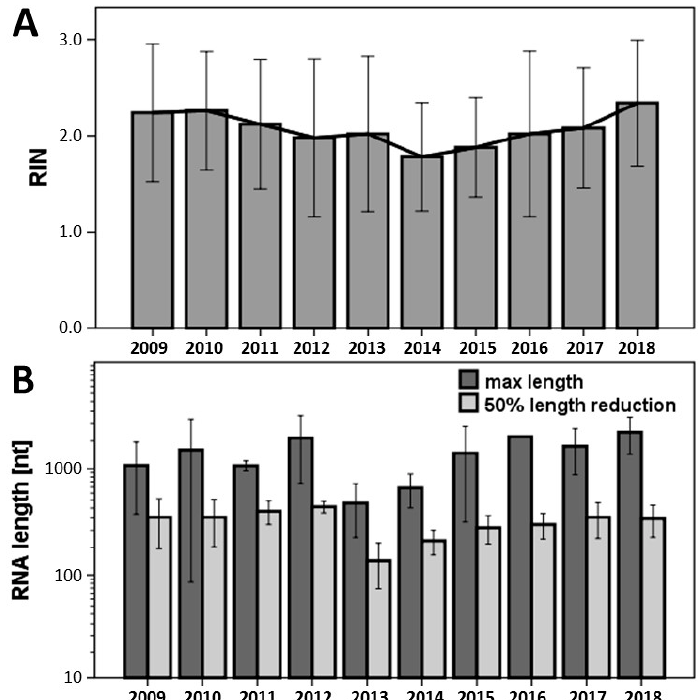
Figure 5. ( A ) Measurement of RNA integrity number (RIN) in FFPE vascular tissue samples using Agilent Bioanalyzer between 2009 and 2018 ( n = 5 for each group and year). ( B ) Evaluation of the length of the RNA fragments, as described in Figure 3. No significant differences were observed between the study years over